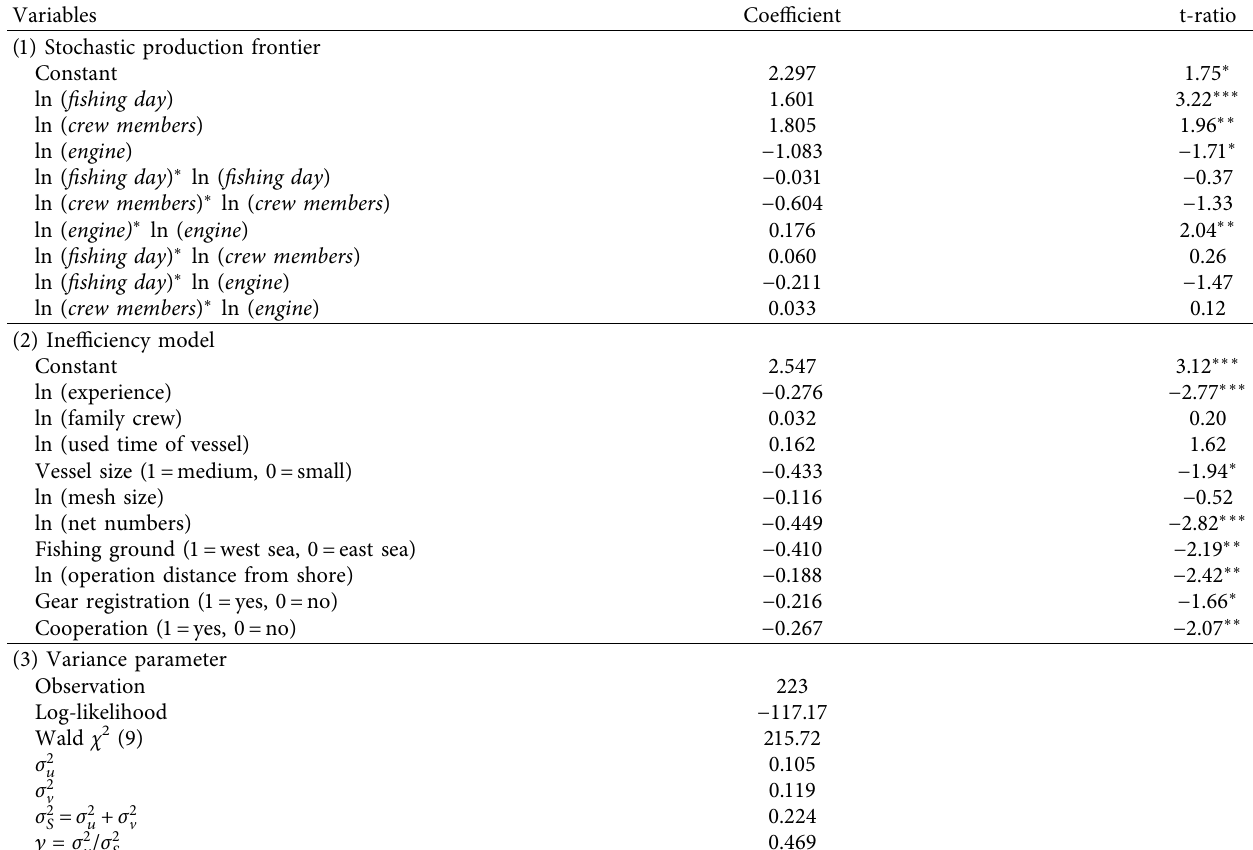
Table 3: Parameters estimate of stochastic production frontier and technical inefciency models.